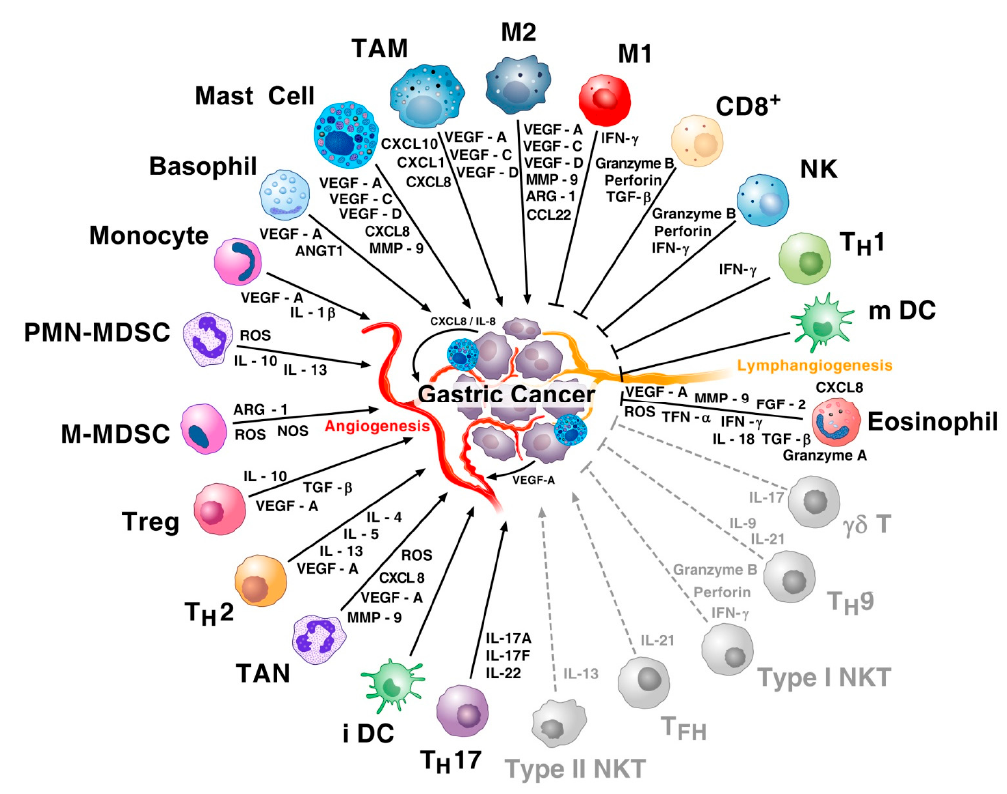
Figure 1. Representation of the immune landscape of human gastric cancer. The immune network in gastric cancer is a complex and dynamic system characterized by multiple interactions between a wide spectrum of immune cells, their mediators and tumour cells. Tumour-associated macrophages (TAM), M2 macrophages, tumour-associated mast cells, basophils, monocytes, polymorphonuclear-myeloid-derived suppressor cells (PMN-MDSCs), monocyte-derived suppressor cells (M-MDSCs), Tregs, Th2 cells, tumour-associated neutrophils (TAN), immature DCs (iDCs), Th17 cells and their mediators play protumorigenic roles. M1 macrophages, cytotoxic CD8 + T cells, NK cells, Th1 cells, mature DCs (mDCs) and their mediators play an anti-tumorigenic role in gastric cancer. VEGF-A and CXCL8 produced by tumour cells can activate tumour angiogenesis. Mast cells and macrophages are major producers of lymphangiogenic factors (VEGF-C and VEGF-D). The anti-tumorigenic role of Th9 cells, type I NKT cells and γδ T cells (grey and dashed lines) have been demonstrated in several other human cancers or are under investigation in gastric cancer. There is increasing evidence that eosinophils play an anti-tumorigenic role in di ff erent cancers [162–164]. The protumorigenic role of circulating Tfh cells [165] and of type II NKT cells has been preliminarily shown in gastric cancer or in several other human tumours, respectively (grey and dashed